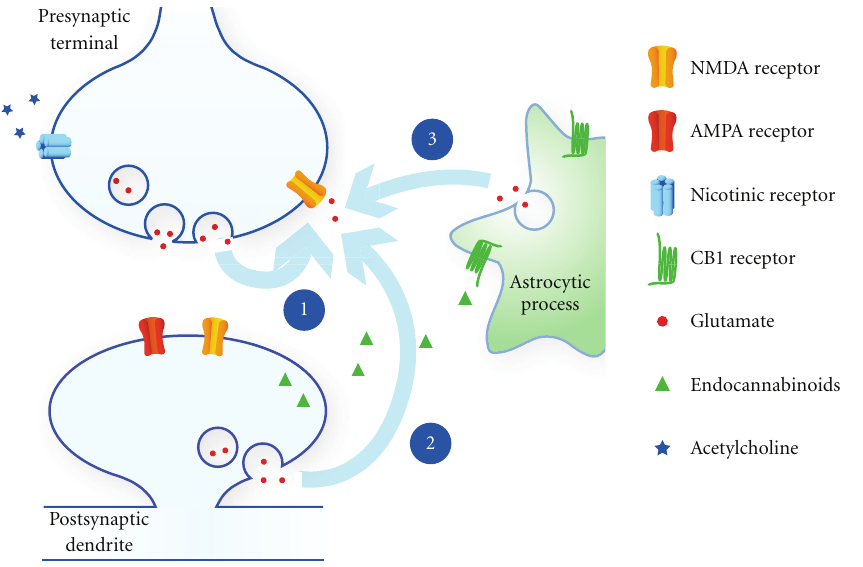
Figure 1: Three possible sources of glutamate for preNMDAR activation. (1) The first and most straightforward route would be that preN- MDARs are auto-receptors that receive glutamate from the same terminals on which they are located. A problem with this scenario is that the necessary depolarisation for NMDAR activation may have ended by the time glutamate has reached the receptor. Therefore, preNMDARs will either need to be less voltage-sensitive or require some other source of depolarisation. (2) A second possibility is that glutamate derives from the post synaptic cell. In a post-before-pre pairing protocol, the depolarisation of the postsynaptic neuron can elicit glutamate release which will activate preNMDARs when these are depolarised by the presynaptic action potential. (3) eCBs, released postsynaptically following depolarisation, can act on CB1Rs on nearby astrocytes to induce astrocytic glutamate release. The question is whether this mode of glutamate delivery will be fast enough to play a role in the tLTD induced at small pairing intervals in the range of a few tens of